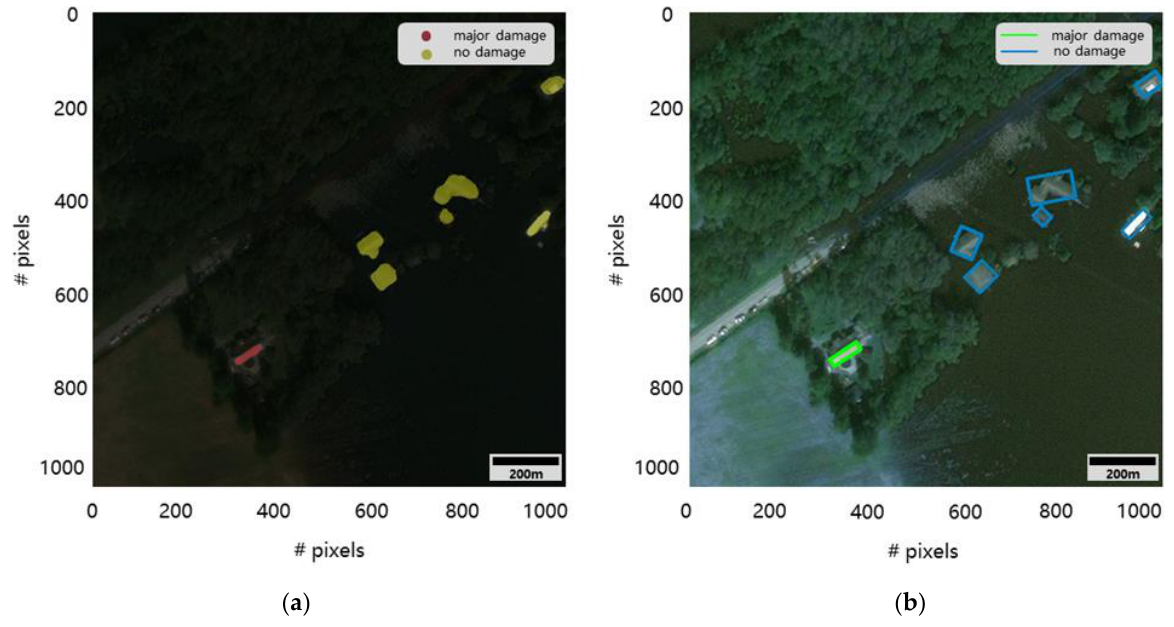
Figure 7. Rotation detection implementation of SegDetector. ( a ) shows the pixel-by-pixel result calculated by SegDetector and ( b ) shows the rotating detection result calculated by SegDetector.